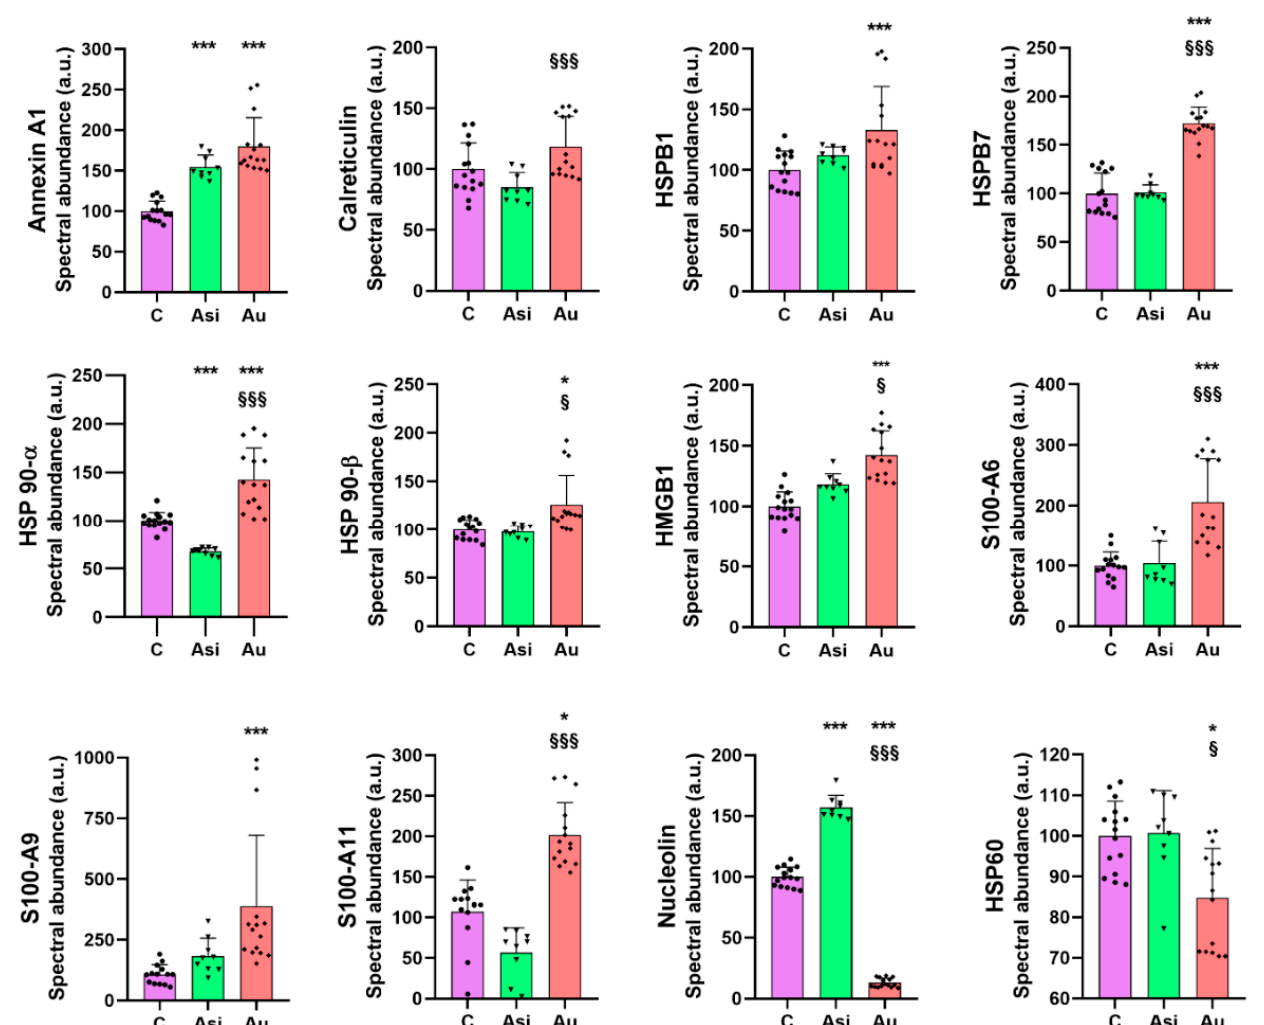
Figure 7. Histograms demonstrating the relative mass spectrometric normalized abundance for selected alarmins. The average ± SD of 5 biological replicates (with the exception of Asi, where n = 3) is plotted. The statistical significance over the C samples is represented by * (* p < 0.05, *** p < 0.001), while the one over Asi is visible with § (§ p < 0.05, §§§ p < 0.001). The scatter plot type histograms include both technological and biological values.